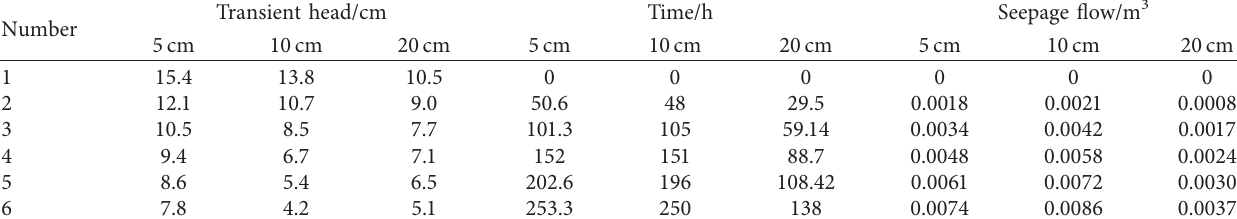
Table 5: Transient head-time-seepage flow relationship.